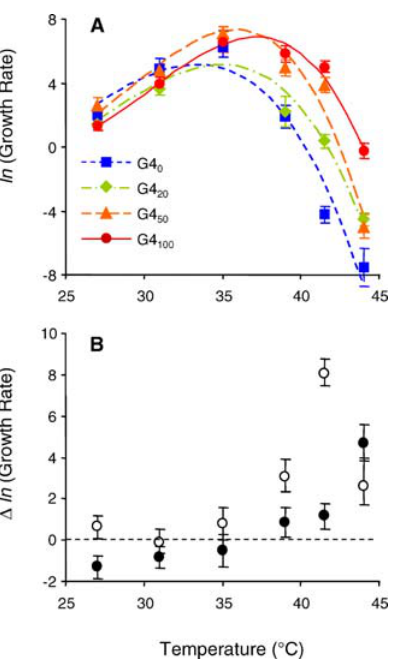
Figure 3. Correlated Responses to Adaptation at High Temperature (A) Reaction norms estimated using TMV explain 71.79% of the sums of squares in the data. Data are mean growth rates 6 s.e.m. for each phage genotype determined from three or four replicate measures at each temperature. (B) Correlated responses to selection at 41.5 8 C (transfers 1– 50; open circles) and to selection at 44 8 C (transfers 51–100; closed circles). Data are the differences in mean ln(growth rate) 6 s.e.d. between G4 50 and G4 0 , and between G4 100 and G4 50 , respectively. DOI: